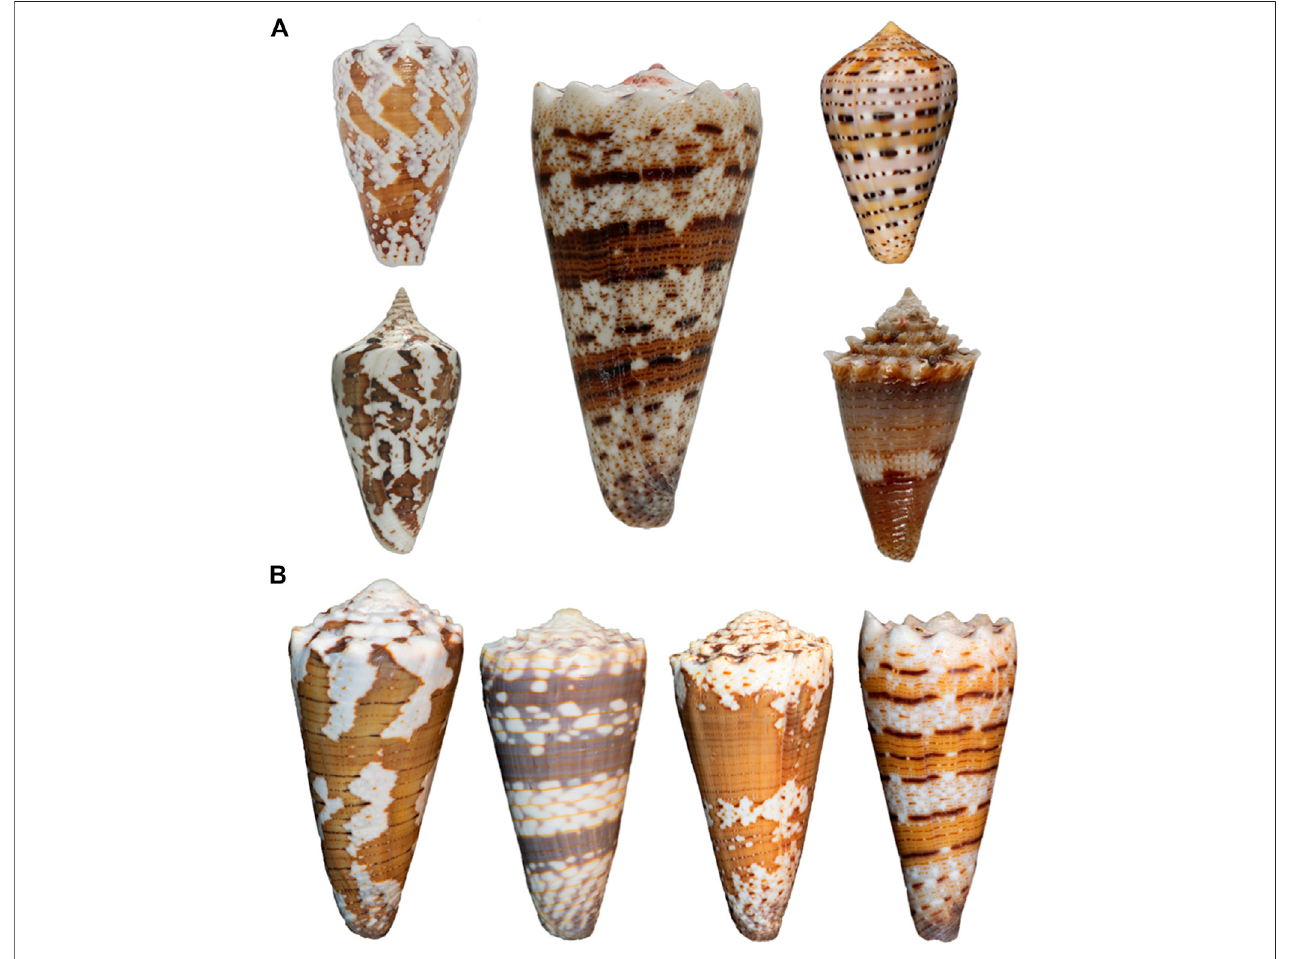
FIGURE 1 | (A) Cone shells of Stephanoconus species. Left top, Conus regius (Florida); Left bottom, Conus archon (West Mexico); Center, Conus imperialis (Philippines); Right top, Conus genuanus (West Africa); Right bottom, Conus chiangi (Philippines, 150 – 250 m). (B) Variation in Indo-Paci fi c Stephanoconus . From left to right: Conus imperialis fuscatus (sometimes called viridulus ; Zanzibar, East Africa); Conus zonatus (Laccadive Islands, India); Conus imperialis variety (Reunion Island); Conusimperialis variety(BalicasagIsland,Philippines,gillnets,70 – 120fathoms).Allfourformsmayrepresentdifferentspeciesfromthe Conusimperialis specimen shown in A , but only Conus zonatus is generally accepted as being different (Photography by Sam Watson and Sam Espino.)